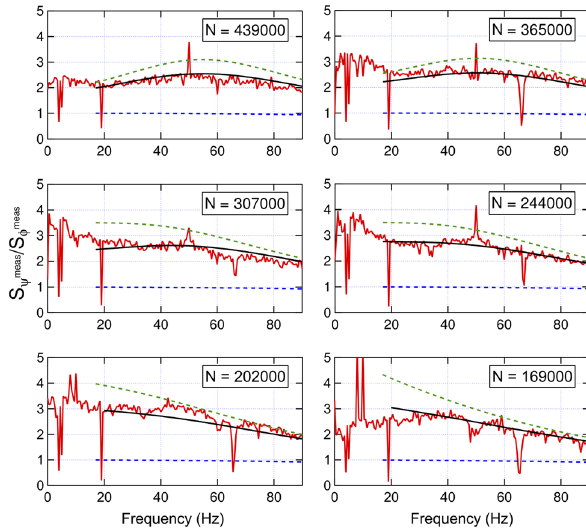
Fig. 16 Plots of the ratios of the ellipticity noise to the rotation noise. Fits are taken from 20 and 90 Hz. The peak frequencies have been excluded in the fits. See text for